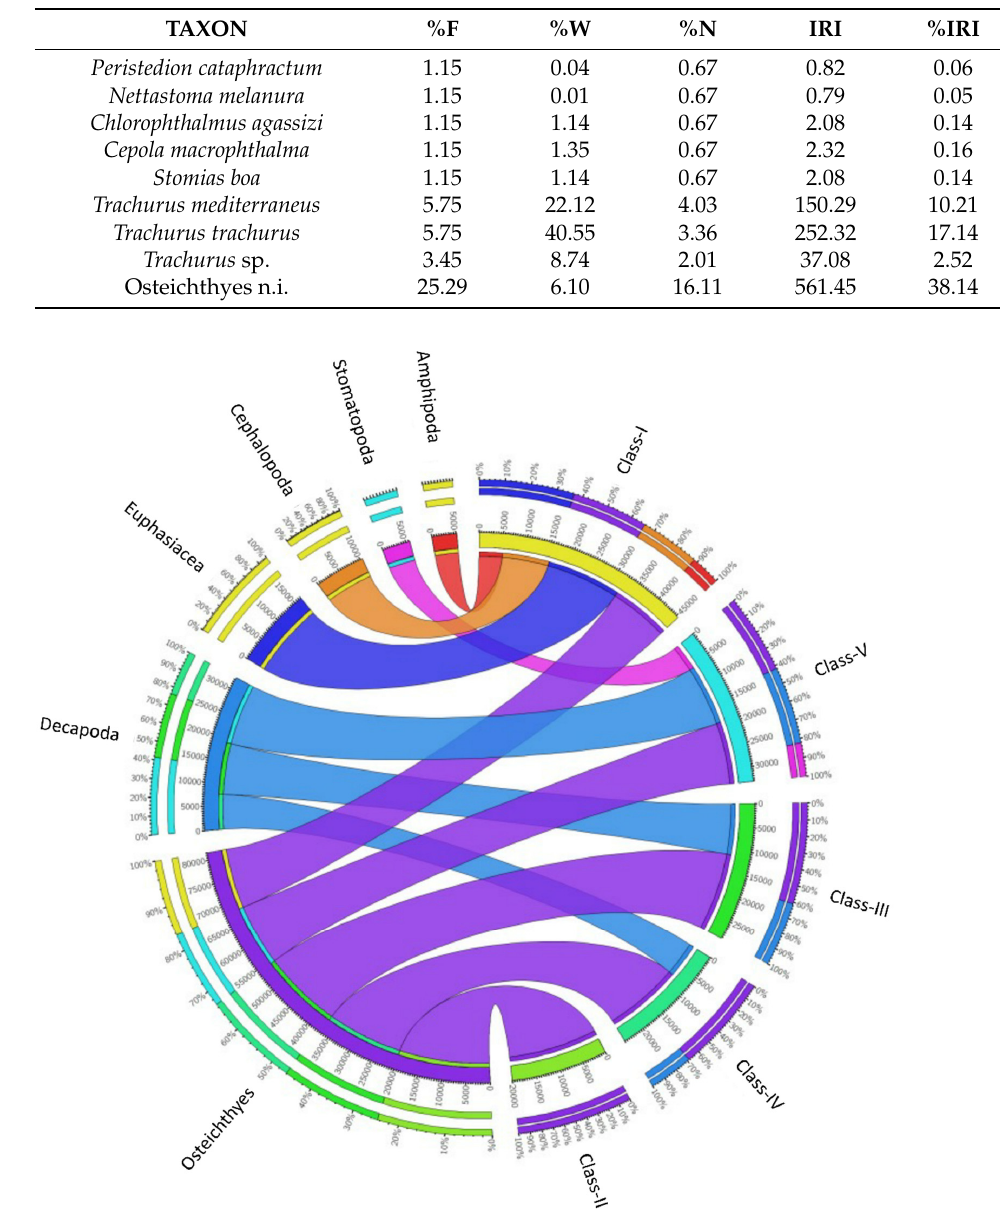
Figure 8. Diet composition of the Merluccius merluccius specimens collected from southern and central Tyrrhenian Sea during 2020. The chord diagram shows the connection among the main taxa found in the stomach contents of different hake size classes investigated. The size classes analyzed are shown on the right of the diagram. Main taxa found are shown on the left. Ribbon size in the chart codifies IRI value associated with hake size classes/prey taxa segment pair.